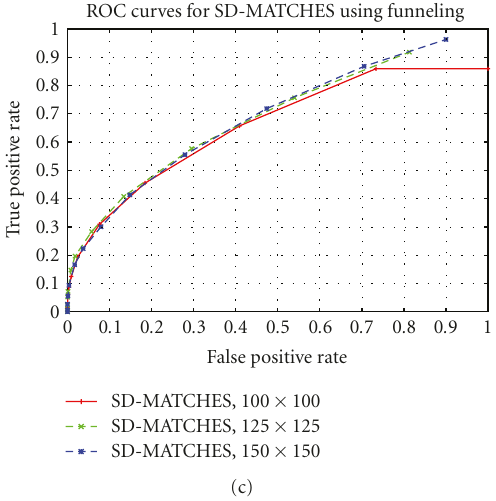
Figure 8: Comparison of the best working flavors of each method when funneling is used: (a) H-X-X, (b) GJD-BC, (c) SD- MATCHES.